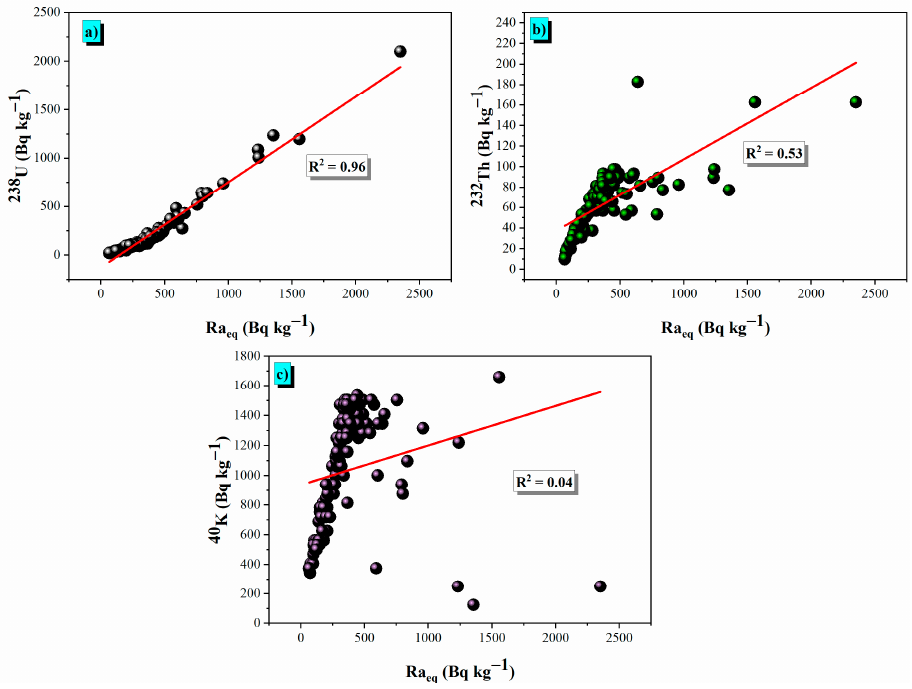
Figure 7. The correlation between the radium equivalent content and the activity concentrations of ( a ) 238 U, ( b ) 232 Th, and ( c ) 40 K in the muscovite granites.